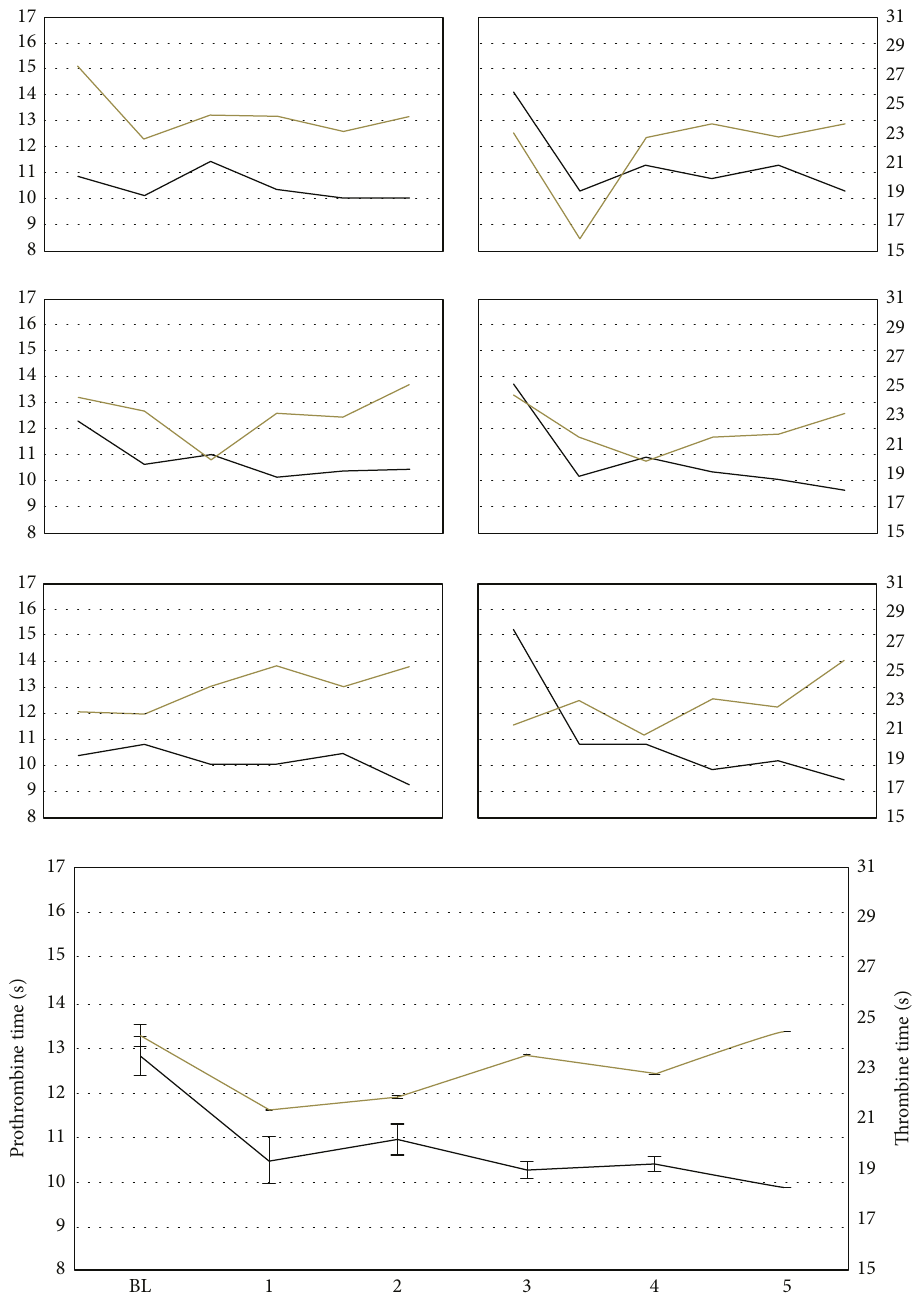
Figure 3: Prothrombin (black line) and thrombin (gray line) times for each studied female (small graphs) and as an average of the six animals (bigger graph) in the samples collected during the baseline (BL) period and after each CHC administration. The x -axes of small graphs are the same as in the bigger graph. Error bars represent standard